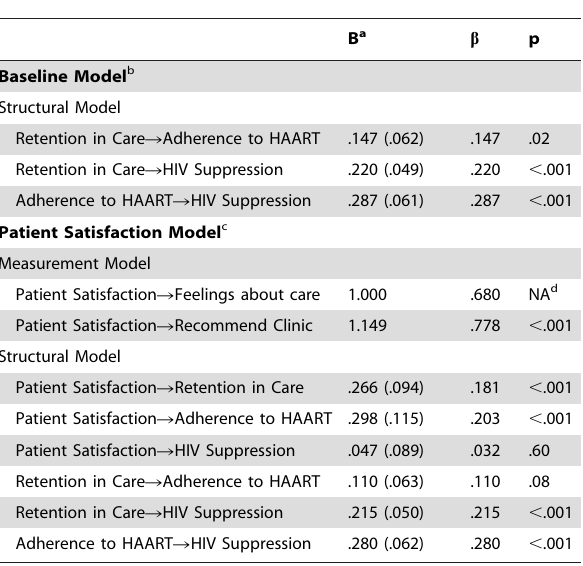
Table 3. Parameter